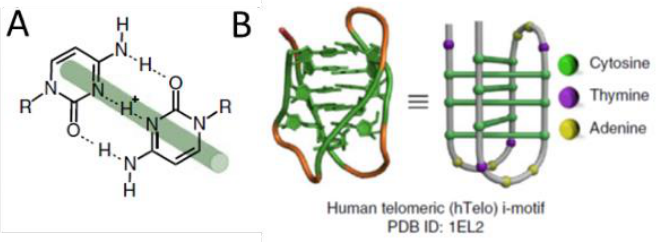
Figure 1. ( A ) Hemi-protonated CC base pair. ( B ) Schematic representation of the structure of the telomeric i-DNA.